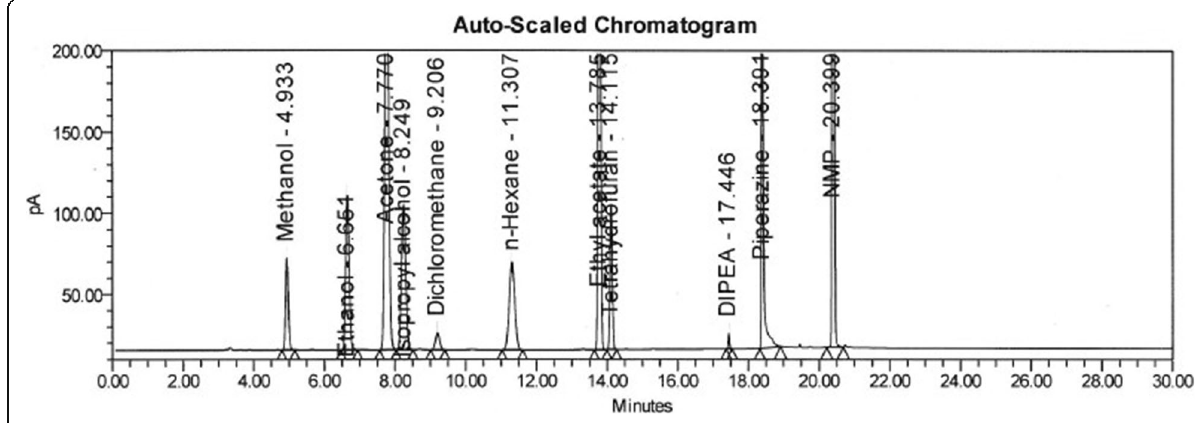
Fig. 3 Typical Chromatogram of Standard